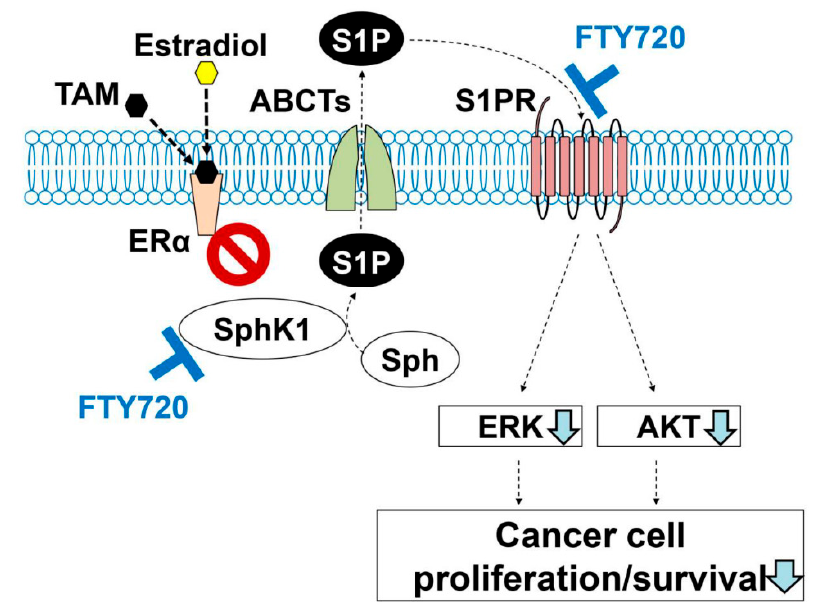
Figure 5. Scheme of blockade of S1P signaling in estrogen receptor (ER)-positive breast cancer (BC) with hormone therapy resistance. In the situation of hormone therapy resistance with higher production and release of S1P by constitutive activation of SphK1, FTY720 can effectively inhibit S1P signaling by blocking both SphK1 and S1PR1.